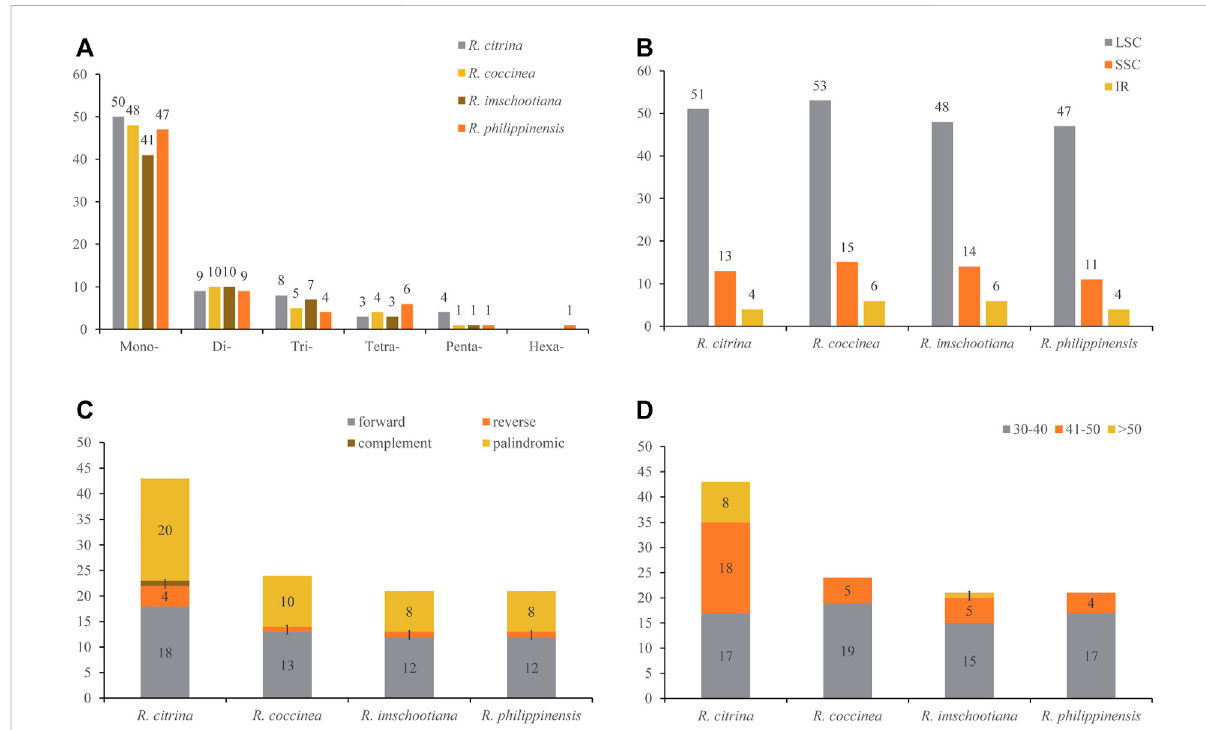
FIGURE 2 Distribution of sequence repeats in the plastid genomes of four species of Renanthera . (A) Number of different short sequence repeat (SSR) types detected in four plastid genomes of Renanthera ; (B) Frequencies of identi fi ed SSRs in large single-copy (LSC), small single-copy (SSC) and inverted repeat (IR) regions; (C) Number of long repeats based on types; (D) Number of long repeats by sequence